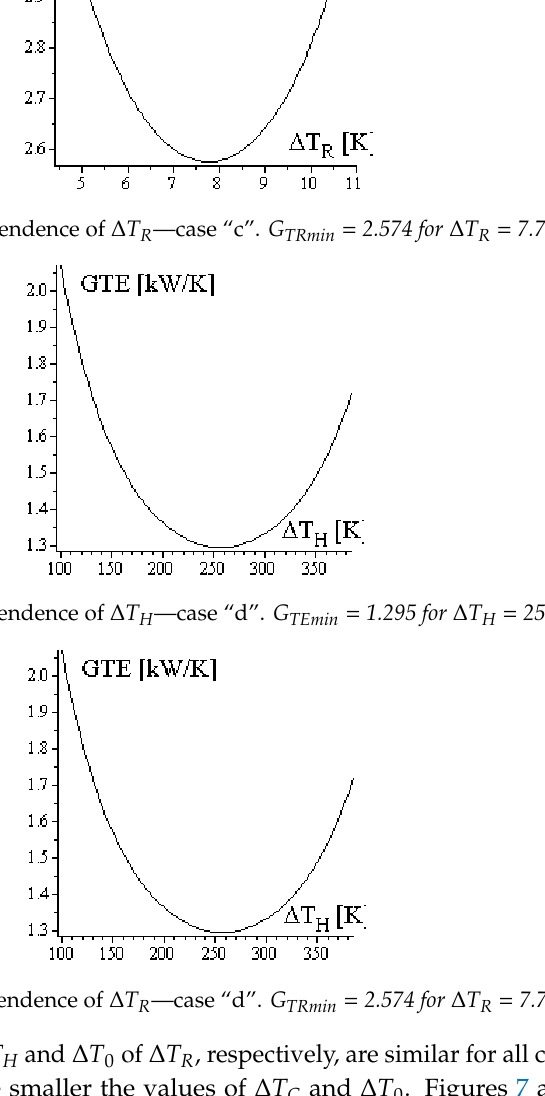
TRmin = 2.574 for Δ T R = 7.77 K.